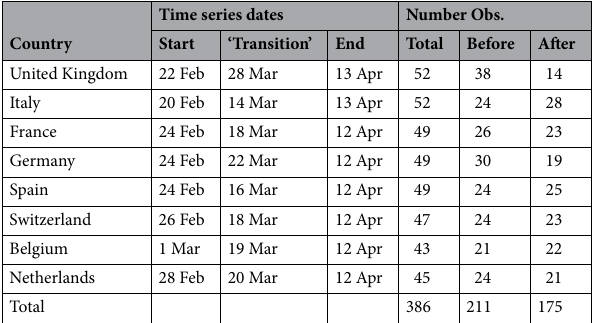
Table 2. Start and end dates and number of observations of cases time series. The transition date used, including incubation time of five days, and the number of observations used in the ‘pre’ and ‘post’ lockdown period.